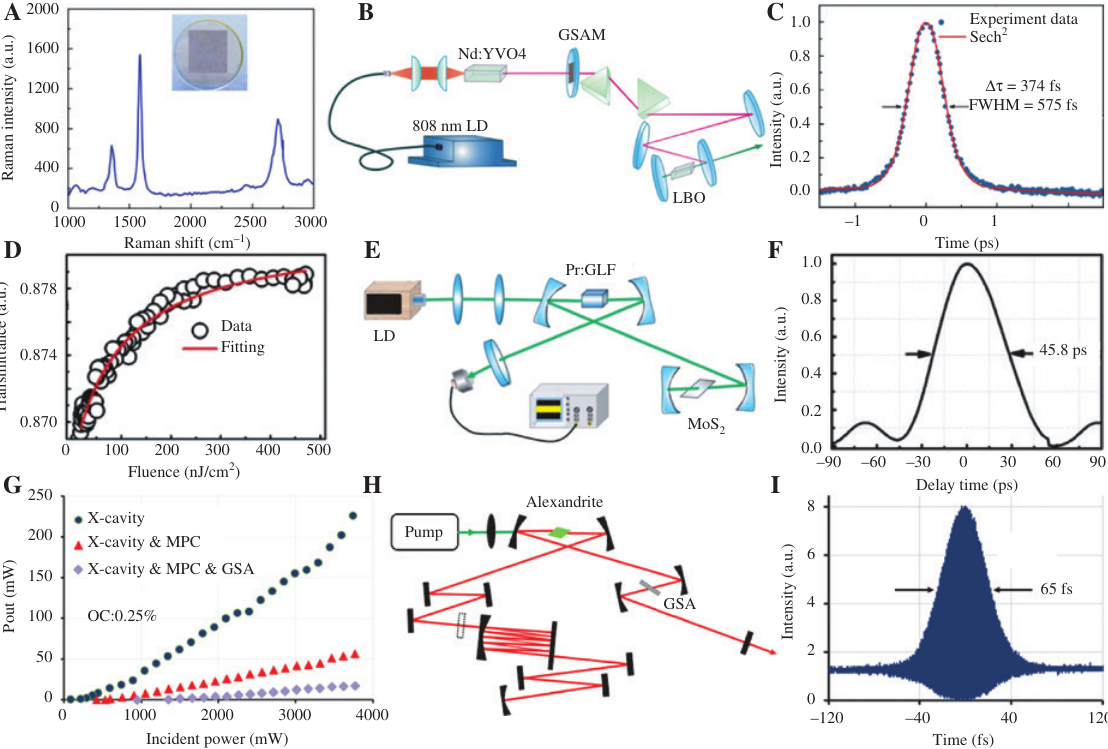
mode-locked lasers in visible region. Figure 8: Performance of graphene and MoS 2 (A) Raman spectrum and photograph of the graphene SA mirror; (B) setup of the passively mode-locked visible laser; (C) autocorrelation trace. Reproduced with permission [128]. Copyright 2013, IOP Publishing. (D) Nonlinear curve of MoS sample; (E) schematic, (F) Autocorrelation 2 curve of the MoS mode-locked visible laser. Reproduced with permission [67]. Copyright 2017, Optical Society of America. (G) Power 2 efficiency curves of the cavity; (H) setup and (I) autocorrelation trace of graphene mode-locked Alexandrite laser. Reproduced with permission [129]. Copyright 2018, Optical Society of